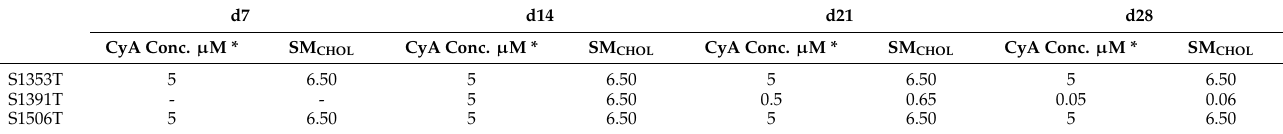
Table 4. Calculated safety margin for the cholestatic risk of CyA in the three PHH donors. d7 d14 d21 d28 CyA Conc. µ M * SM